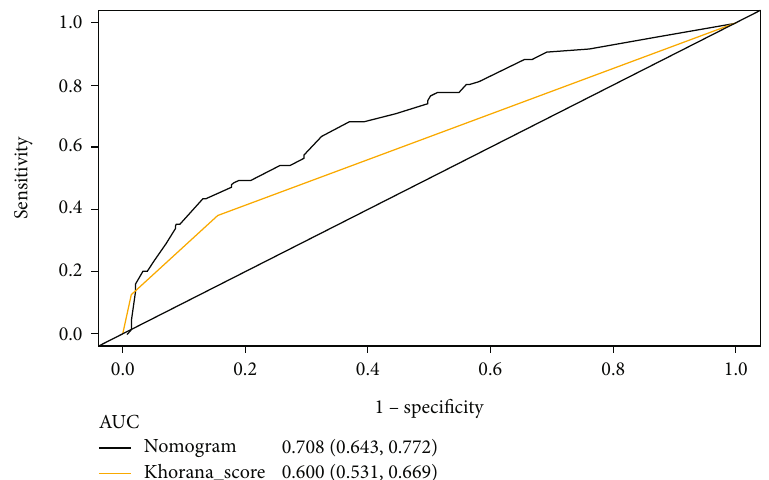
Figure 4: The receiver-operating characteristic (ROC) curve and the area under the ROC curve (AUC) of the nomogram and the Khorana score. Their AUCs were 0.708 and